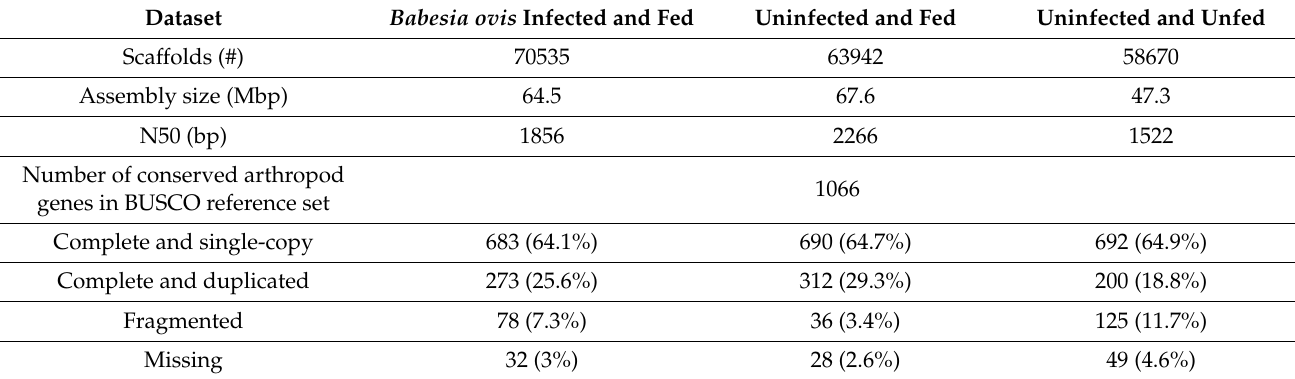
Table 1. BUSCO statistics for each Rhipicephalus bursa sialotranscriptome assembly against an arthropod database. Conserved BUSCO genes were assigned to four classes of genes: missing, fragmented, duplicated, and